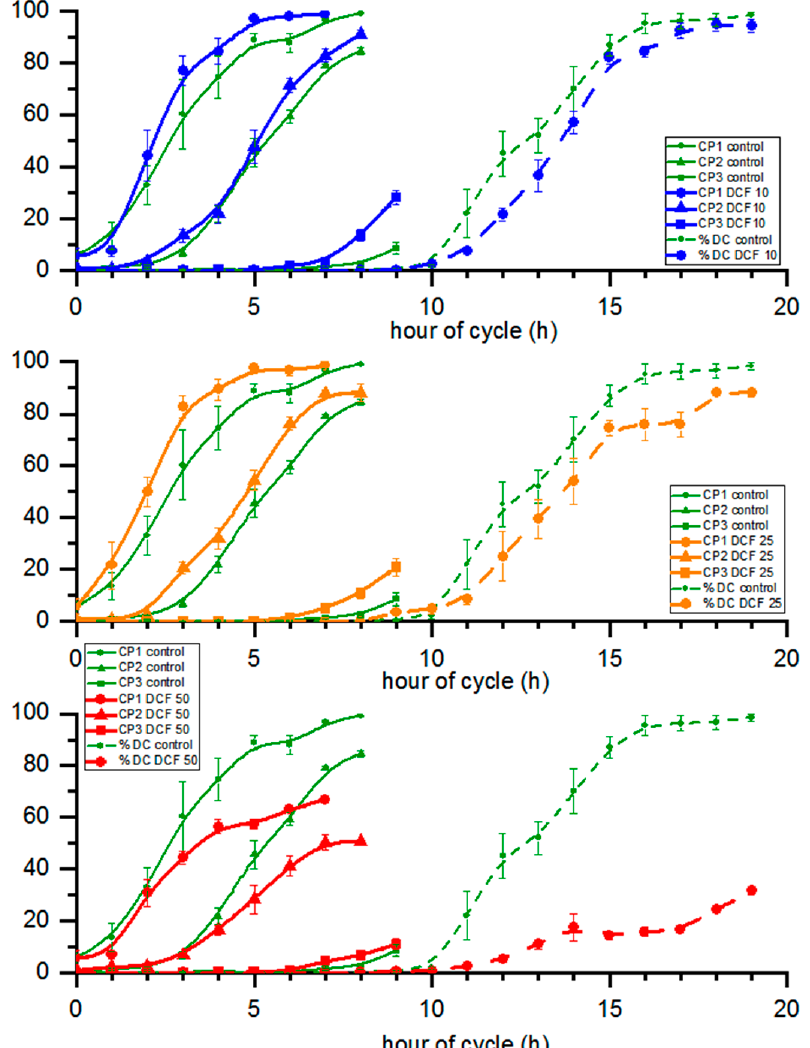
Figure 4. The commitment points and percent of daughter cells of cultures. Data are presented as means ± SE. Attainment of CP1, CP2 and progression of cell division of DCF50 and attainment of CP3 of DCF10 were statistically significantly different from controls (Tukey’s HSD–Repeated Measures ANOVA, p < 0.05, n = 3). The analysis of nuclear divisions revealed no significant differences between DCF- treated cells as compared to control (Figure